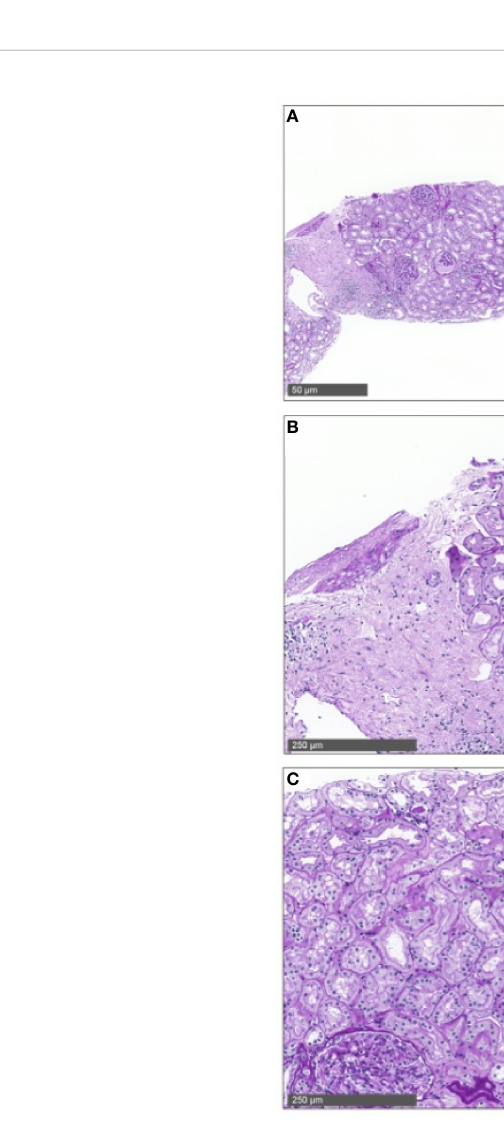
FIGURE 3 | Allograft biopsy no 3 in patient 2. Allograft biopsy of patient 2 18 months post-transplant showing minimal glomerular alterations without signs of acute rejection. This biopsy was taken under minimal immunosuppressive therapy (cyclosporine A level at 13 ug/L), at the same time as the molecular microscope analysis shown in Figure 4